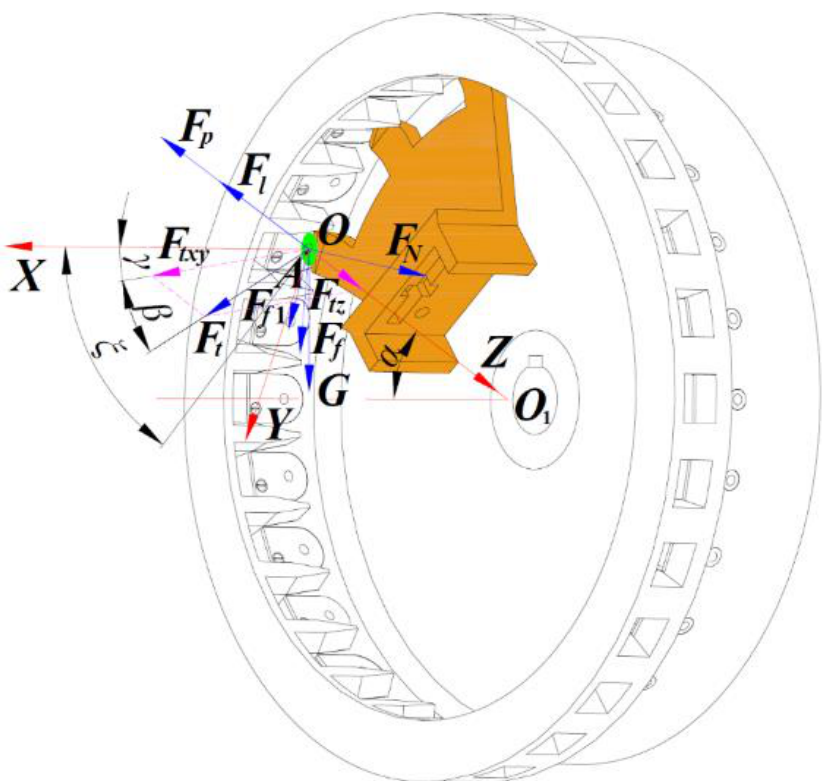
Figure 3. Force analysis of the cotton seed in seed-cleaning process. Note: A , projection point of the critical rollover point on the XOY plane; O 1 , the intersection of Z -axis and central axis of seeding plate; F p , adsorption force on cotton seed, N; F l , centrifugal force, N; G , gravity, N; F N , support force on cotton seed by replacement plate, N; F t , pushing force on cotton seed by scraper, N; F txy , projection from F t in the XOY plane, N; F tz , projection from F t in the Z -axis, N; F f , friction force on cotton seed by scraper, N; F f 1 , friction force on cotton seed by replacement plate, N; α , angle of F l with horizontal plane, ( ◦ ); β , angle of F t with XOY plane, ( ◦ ); γ , angle of F txy with X -axis, ( ◦ ); and ξ , angle of the straight line OA with X -axis, ( ◦ ).